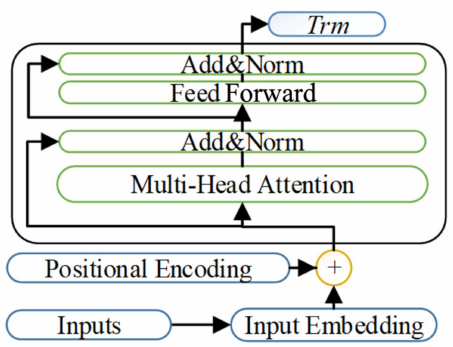
Figure 4. Transformer structure